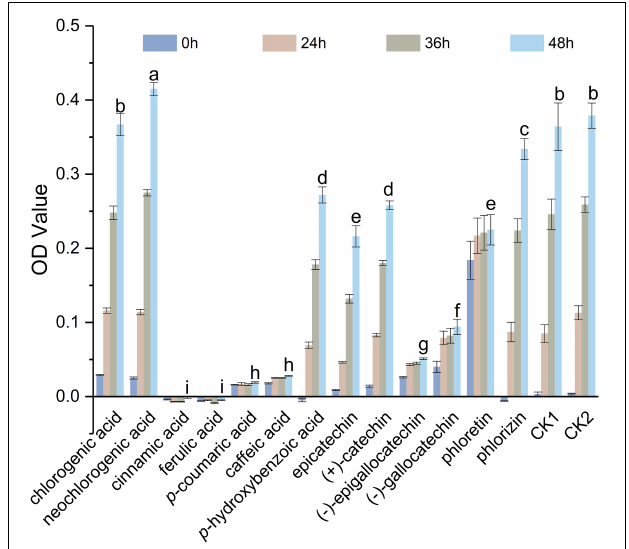
FIGURE 1 | Antibacterial activities of polyphenols against S. maltophilia 4–1. CK1, solvent control; CK2, NB medium control. Bars with different letters differ significantly ( p < 0.05) by Duncan’s test. All experiments were performed in triplicate.